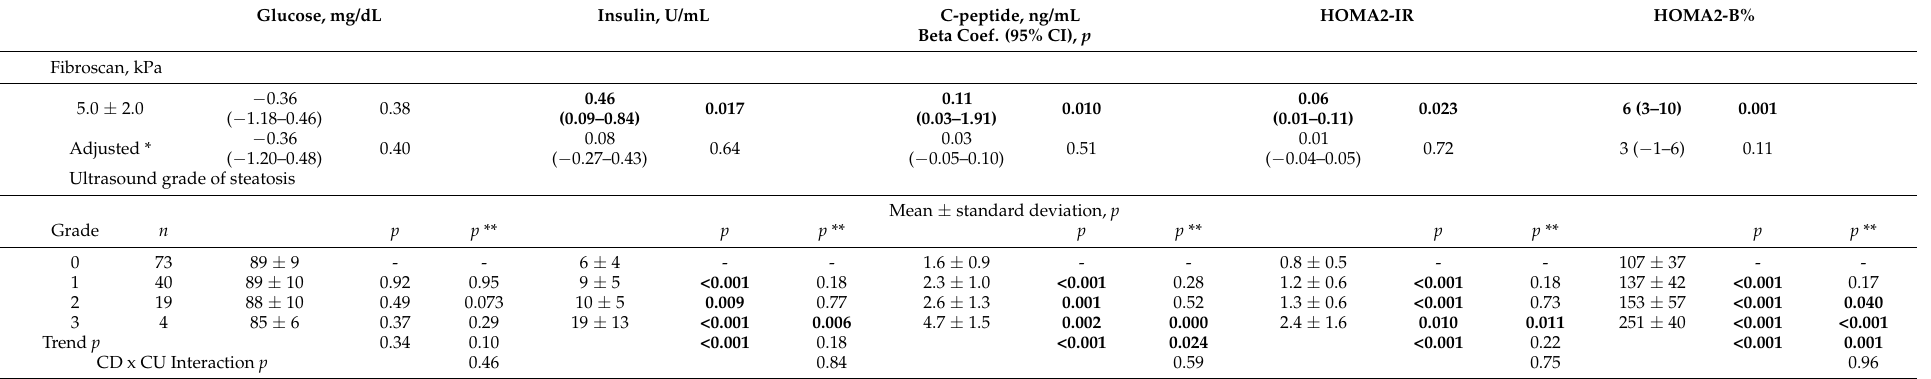
Table 4. Relation of fibroscan and NAFLD to glucose homeostasis-related molecules and IR indexes. Glucose, mg/dL Insulin,